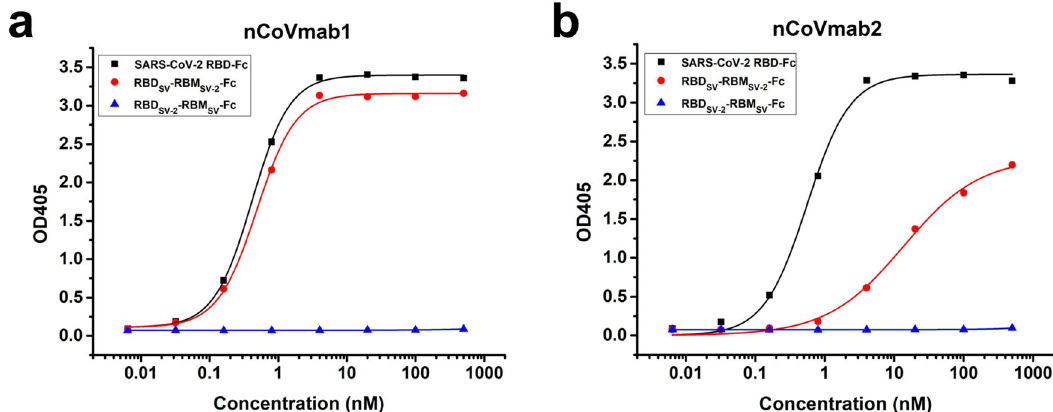
Fig. 5 Determination of the epitopes of nCoVmab1 and nCoVmab2. Binding of nCoVmab1 ( a ) and nCoVmab2 ( b ) to chimeric RBD-Fc fusions. nCoVmab1 could bind to the SARS-CoV-2 RBD and RBD SV -RBM SV-2 with similar binding activities whereas the binding ability of nCoVmab2 to RBD SV -RBM SV-2 was much lower than that of nCoVmab1. Therefore, both antibodies primarily recognized the RBM in the SARS-CoV-2 RBD. The experiment was performed with duplicate samples. Data are average values of two